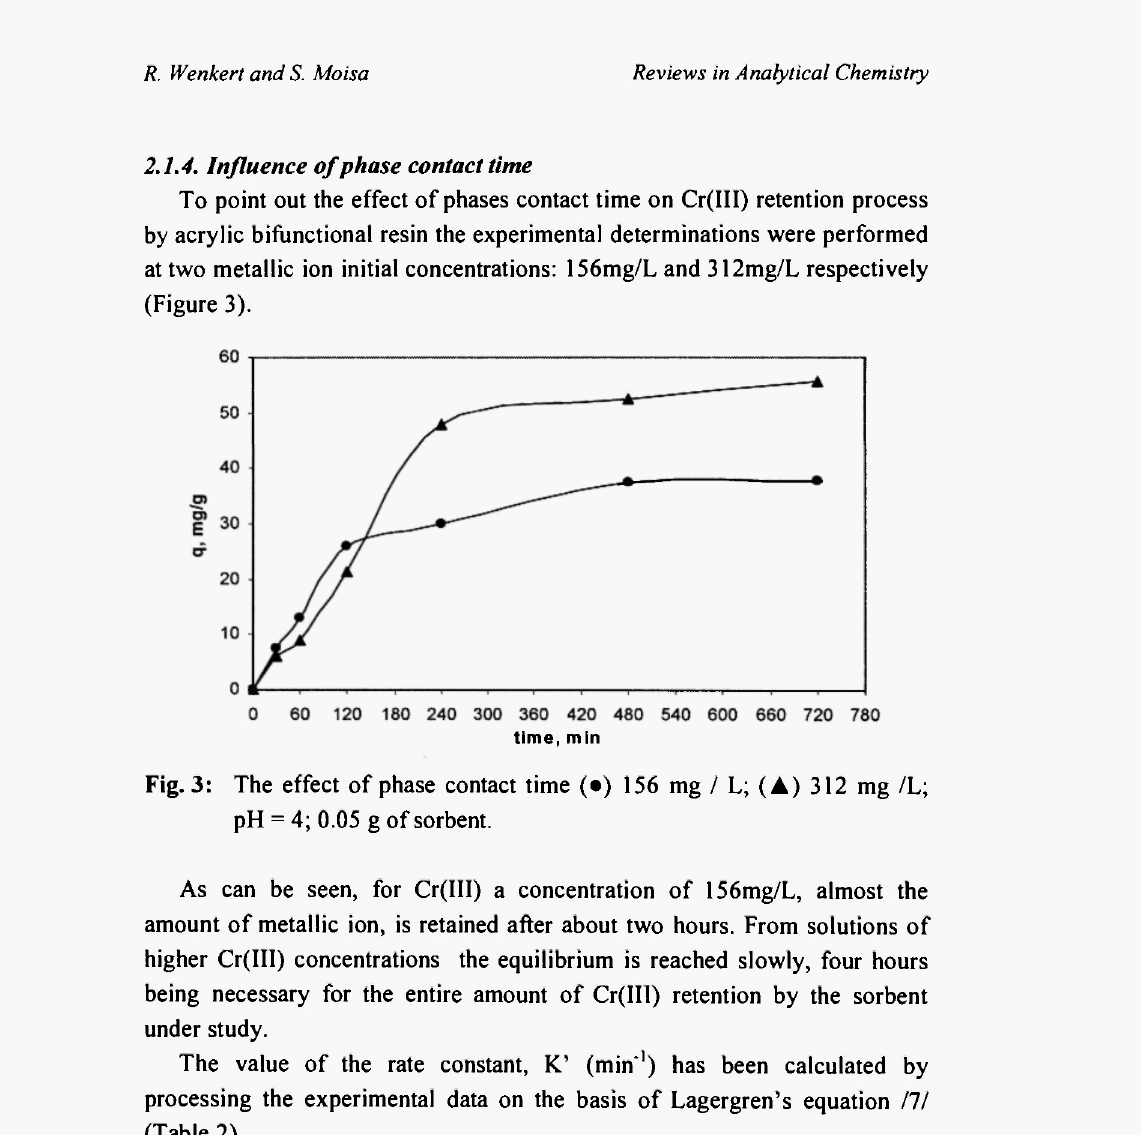
Fig. 3: The effect of phase contact time ( ·) 156 mg / L; ( A) 312 mg /L; pH = 4; 0.05 g of